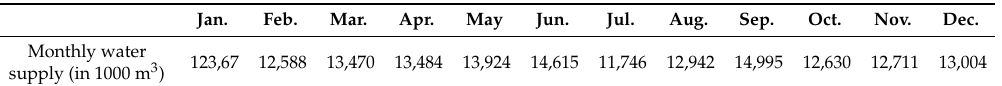
Table 2. The 2016 water supply data of Addis Ababa city.